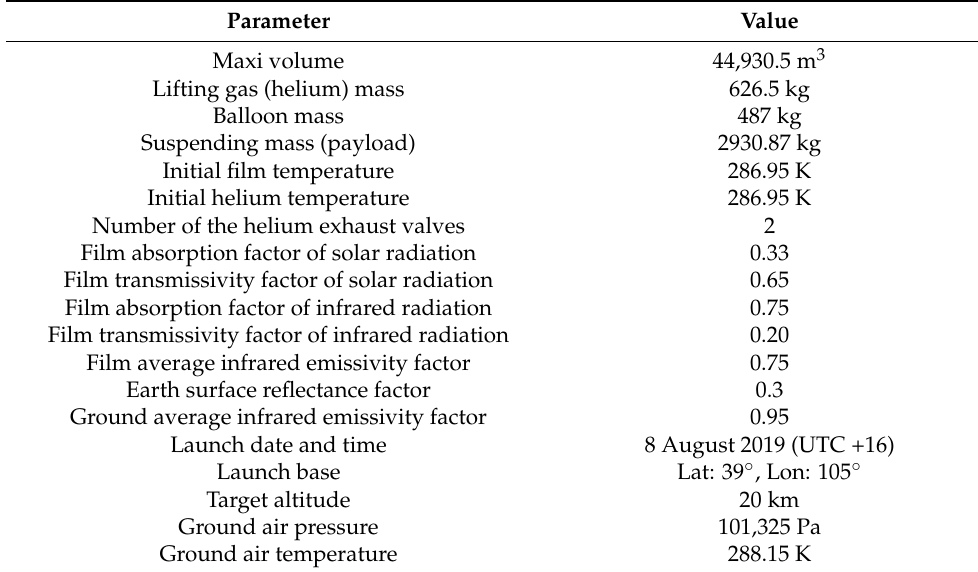
Table 1. Balloon’s specifications and flight simulation information.